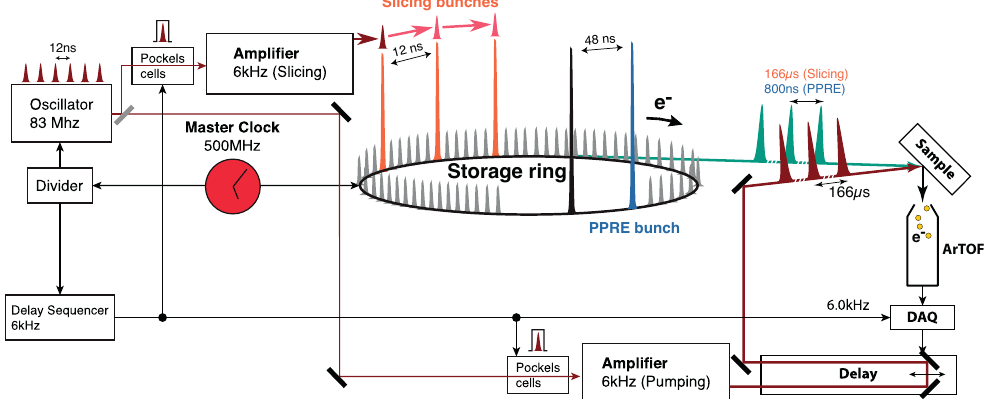
Figure 2. Trigger scheme for a time-resolved photoemission experiment at the FemtoSpeX facility at BESSY II. Two Ti:sapphire amplifiers (Legend Elite Duo, COHERENT), which are seeded by the same oscillator (Micra, COHERENT), are used to drive the slicing process and to pump the sample. The oscillator, running at 83.3 MHz ( (cid:98) = 12 ns), is phase-locked to the master clock of the storage ring. Both lasers are running at 6 kHz ( (cid:98) = 166 µ s). For slicing or femtosecond measurements, a delay sequencer is used which advances the trigger for each 6 kHz trigger by 12 ns to reduce the halo background and improve slicing efficiency. For PPRE or low- α measurements, the delay sequencer is bypassed and the pump laser is synchronized to the PPRE pulse on the other side of the fill pattern. Further information on the trigger scheme and the realization can be found in [10,14]. Adapted from Ref.